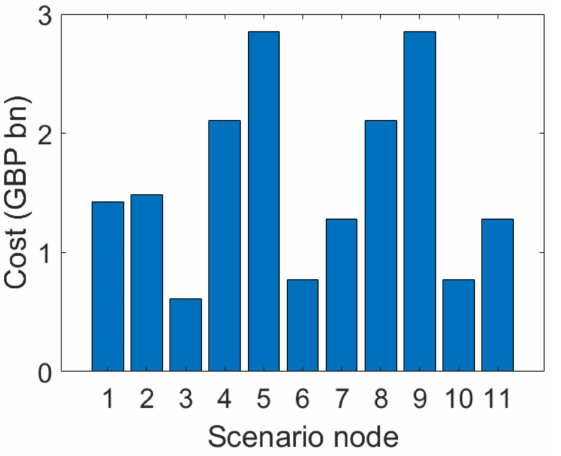
Figure 22. Difference between the optimal accumulated line investment costs for the stochastic studies with and without storage, for every scenario-tree